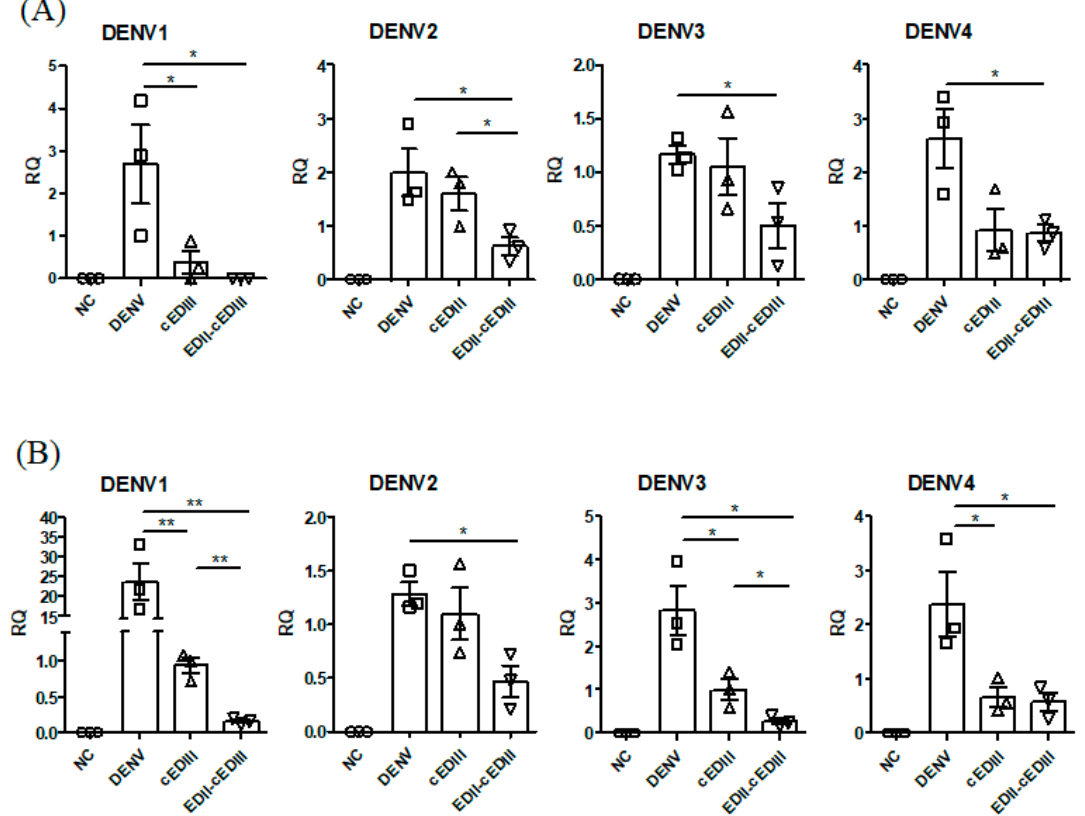
Figure 5. Purified Ab treatment reduces DENV infection at initial infection sites, axillary lymph nodes (LN), and spleen. Viral RNA levels in ( A ) axillary LN and ( B ) spleen were quantified by RT-qPCR 18–24 h after DENV infection of AG129 mice in the presence or absence of the indicated Ab. Data are means ± SE, and a representative result from two independent experiments is shown. Unpaired two-tailed t- test. * p < 0.05 and ** p < 0.01 indicate significant differences. Squares, triangles, and inverted triangles represent the results from DENV-, anti-cEDIII Ab, and anti-EDII-cEDIII Ab-treated groups, respectively.